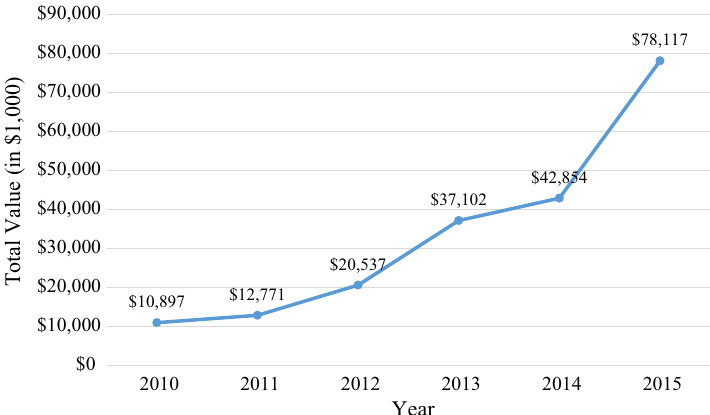
Fig. 1 Total Value of US Hemp Imports, 2010–2015 Notes : The main source of the total value for hemp imports is obtained from the US International Trade Commission, and total hemp imports include hemp seed, hemp oil and fractions, hemp seed oilcake and solids, and true hemp. Please see more detailed information on US hemp import at https:// fas. org/ sgp/ crs/ misc/ RL327 25.